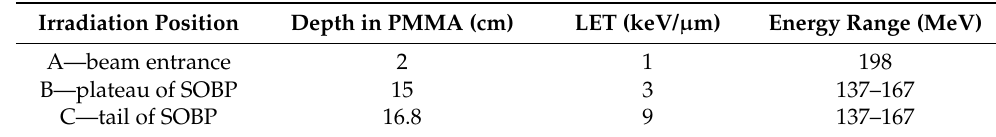
Table 1. Irradiation parameters along the therapeutic proton SOBP.